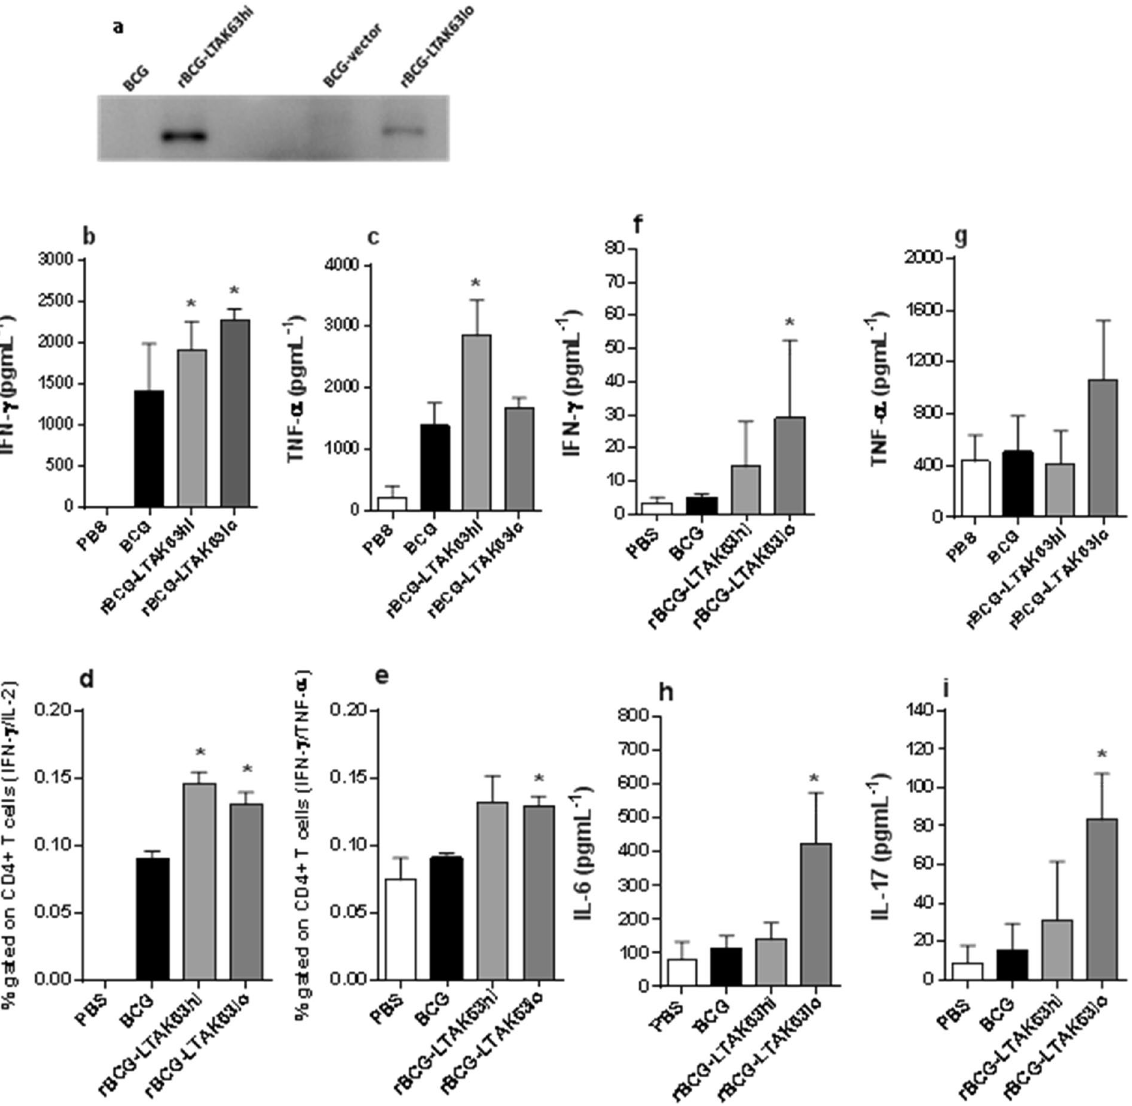
Figure 2. Western blot of different rBCG-LTAK63 constructs and cytokine production in the splenocytes and lungs of mice immunized with these constructs. ( a ) Western blot of total soluble protein extracts from BCG, rBCG-LTAK63 hi , BCG-vector (BCG transformed with the empty pMIP12 expression vector) or rBCG- LTAK63 lo (10 μ g) analyzed using a polyclonal anti-LTAK63 antibody (1:500). BALB/c mice were immunized with either BCG, rBCG-LTAK63 hi or rBCG-LTAK63 lo (1 × 10 6 CFU). Splenocytes were isolated after 60 days and in vitro re-stimulated with CFP to produce ( b ) IFN- γ , and ( c ) TNF- α as determined by ELISA, or ( d ) CD4 + T cells doubly positive for IFN- γ /IL-2 and ( e ) CD4 + T cells doubly positive for IFN- γ /TNF- α . Lung cells were separated and re-stimulated with CFP to produce ( f ) IFN- γ , ( g ) TNF- α , ( h ) IL-6 and ( i ) IL-17. Results are mean ± S.D. ( * ) Differences were considered statistically significant when P ≤ 0.05 as compared to the BCG group (one-way